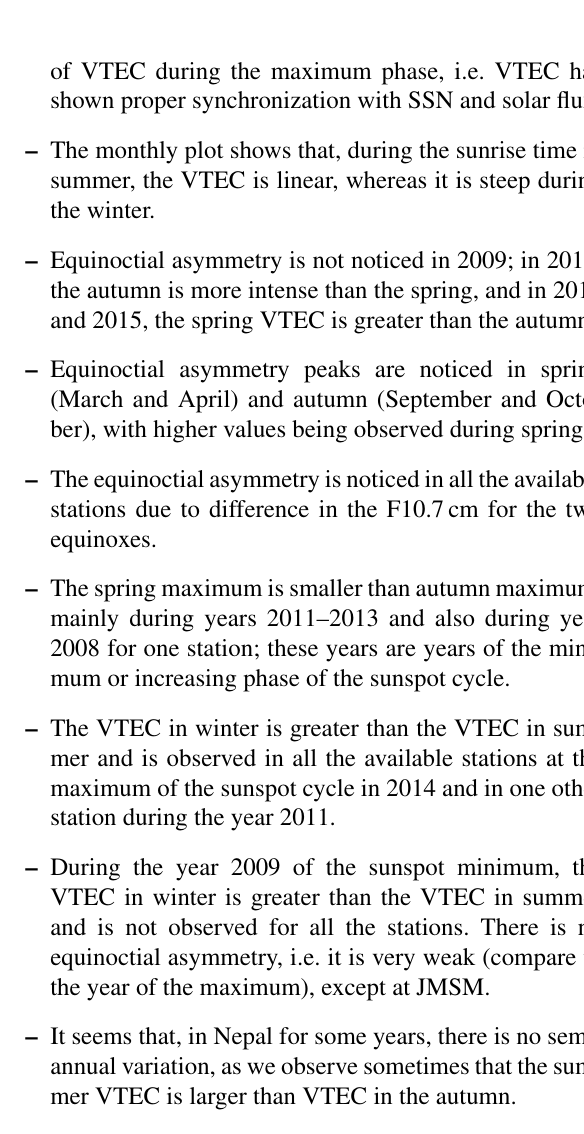
Figure 9. Annual mean VTEC variability in the KKN4, GRHI, JMSM and DLPA stations for the SSN and solar flux during year 2008–2018.